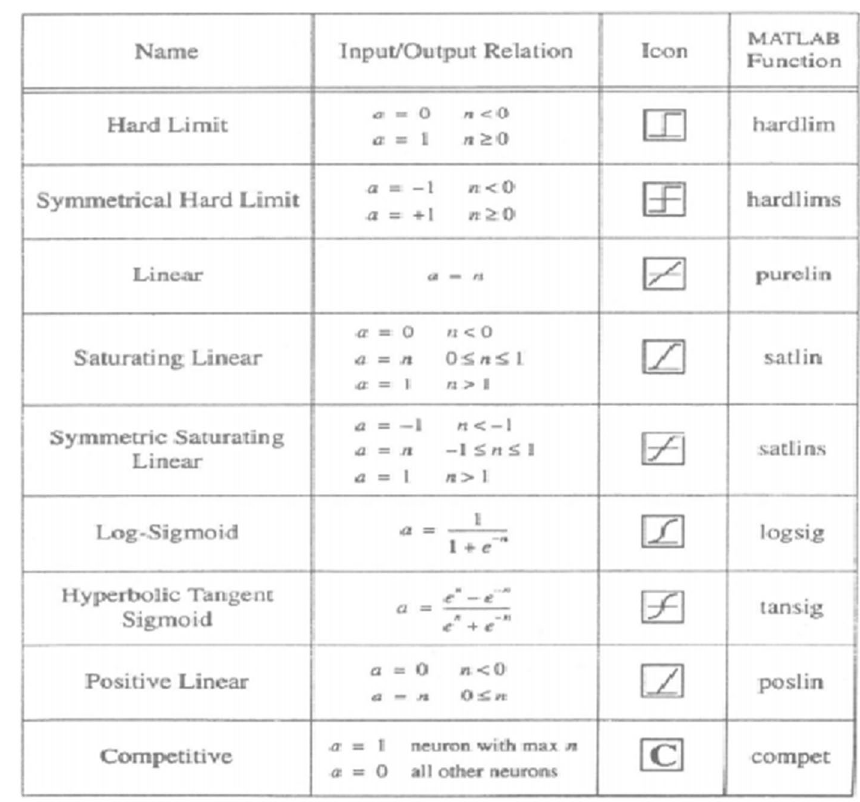
Fig. 4 A number of activation functions used in the ANN (Alborzi 2001)